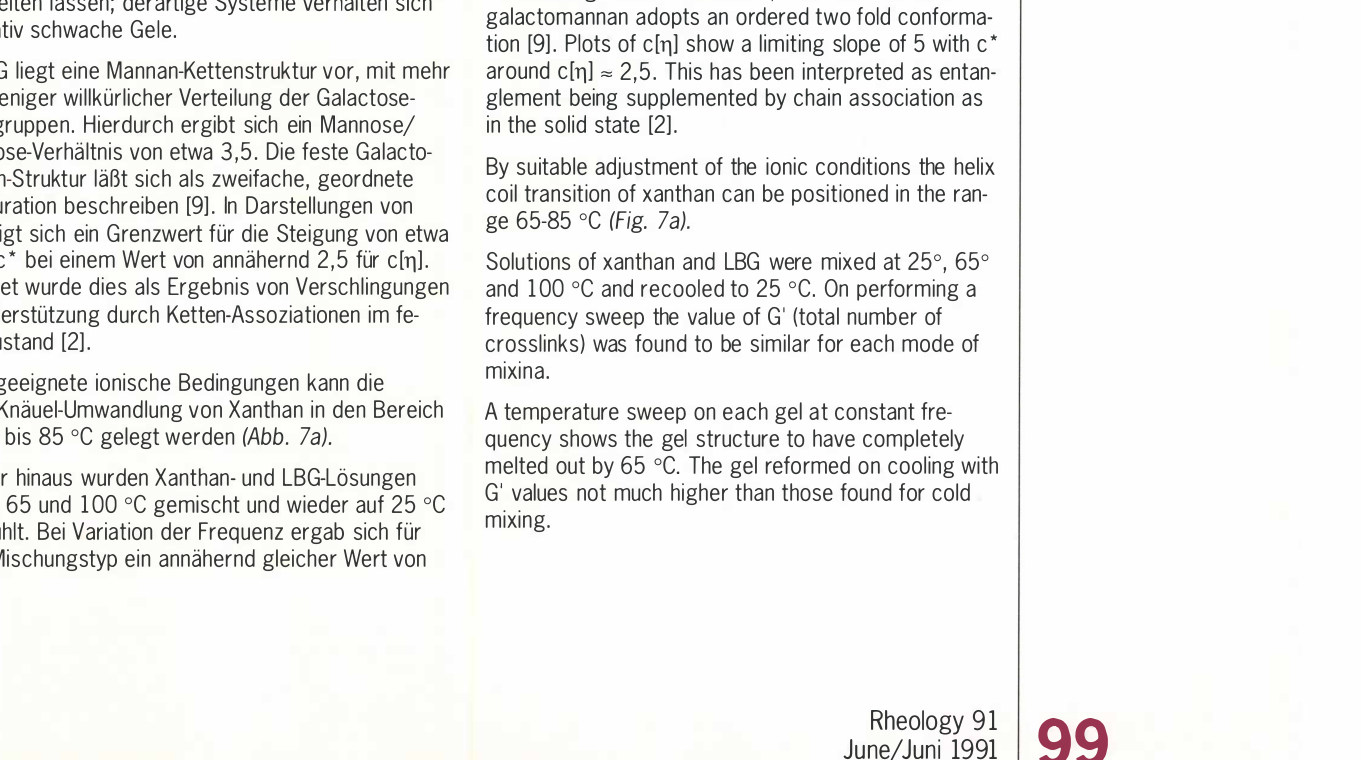
ionic strength show an order-disorder transition on heating which is assumed to be a helix-soil transition [3, 7, 8]. Its commercially important rheological prop­ erties arise from helix-helix association giving rise to weak gel behaviour.